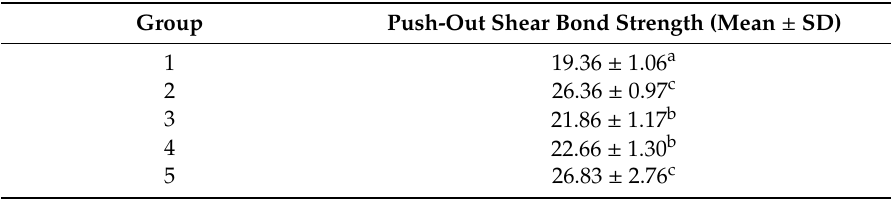
Table 2. The result of push-out shear bond strength between epoxy resin-based fiber post and core resin (MPa).